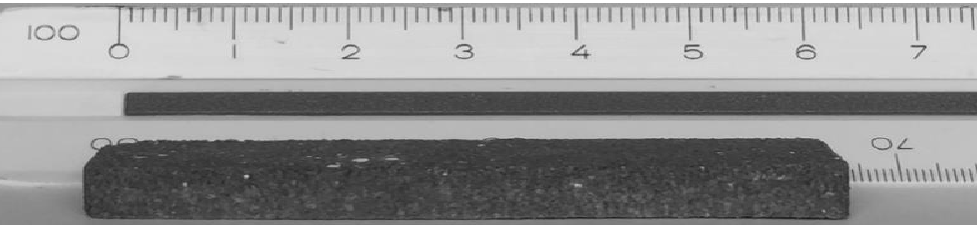
Figure 3. Evolution of the volumetric expansion within the temperature interval of 800 – 950 °C.